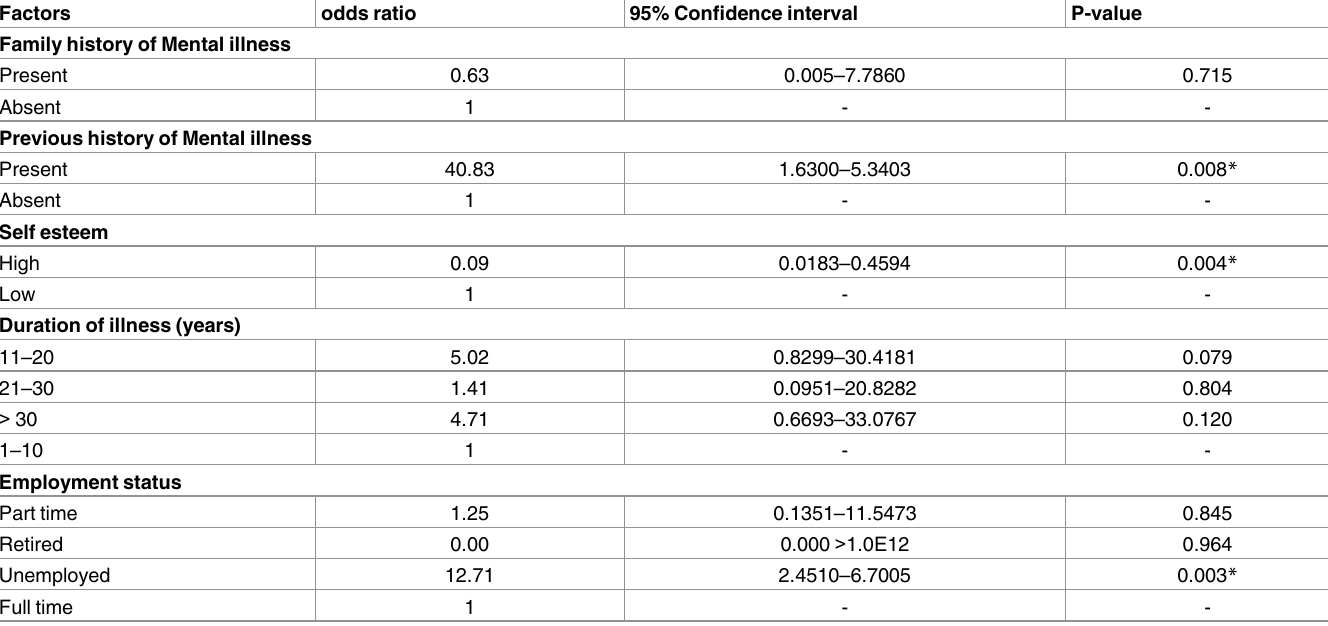
Table 4. Predictors of